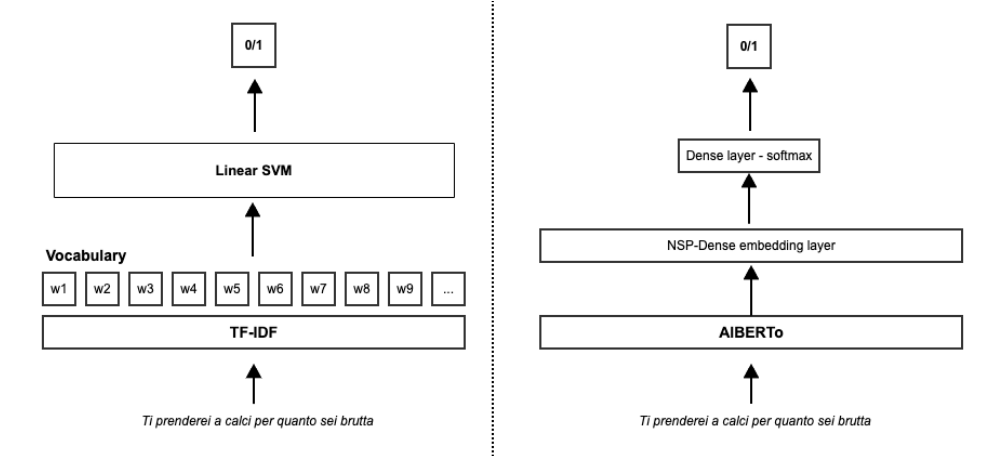
Figure 1. On the left it is showed the SVM model, on the right the one based on